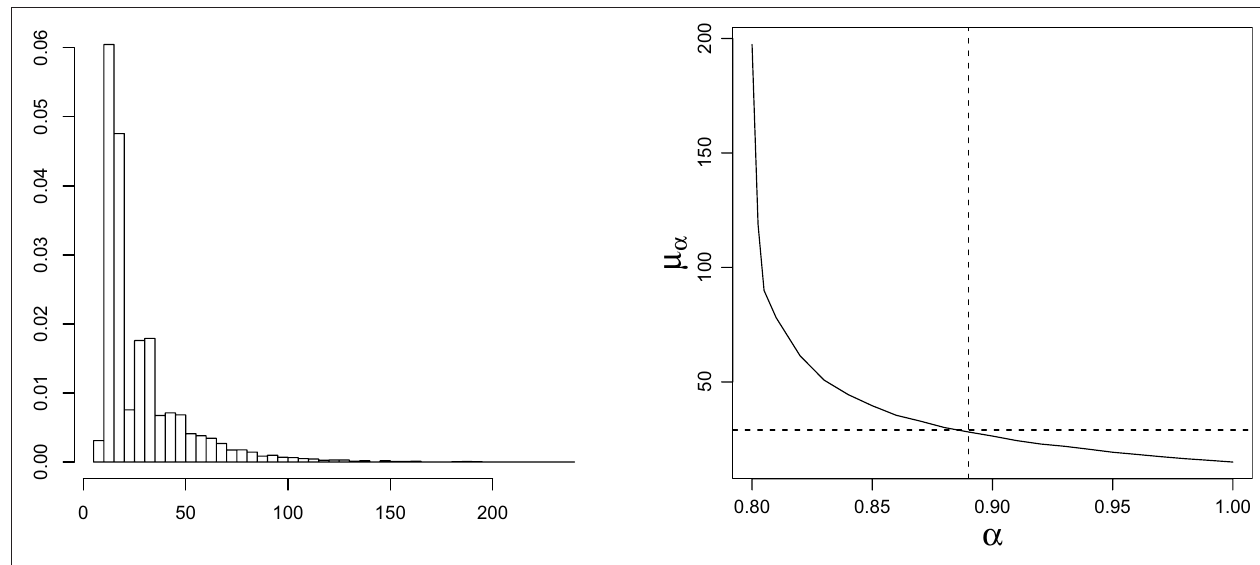
Figure 1 | Left: Histogram of simulated extinction times for α = 0.89. Right: Behavior of μ